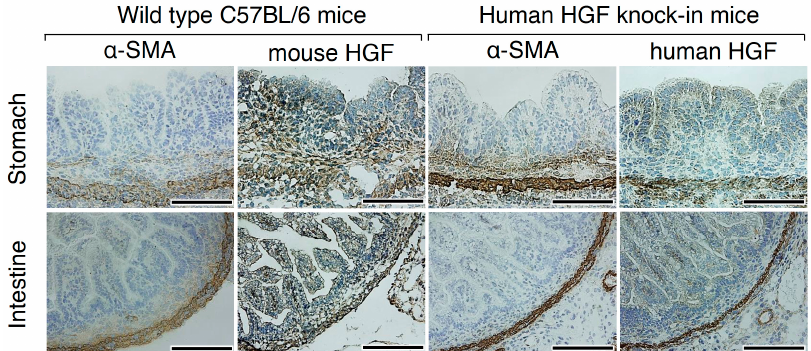
Figure 2. Localization of HGF in the developing stomach and intestine of wild-type C57BL / 6 and hHGF-ki mice. Immunohistochemistry was performed using anti-mouse HGF polyclonal antibodies and t5A11 anti-human HGF monoclonal antibodies, respectively, in C57BL / 6 and hHGF-ki mice. Similar expression and localization patterns were obtained in sections from two different mice. Tissues were obtained from day 16.5 embryos. Scale bars represent 200 µm.